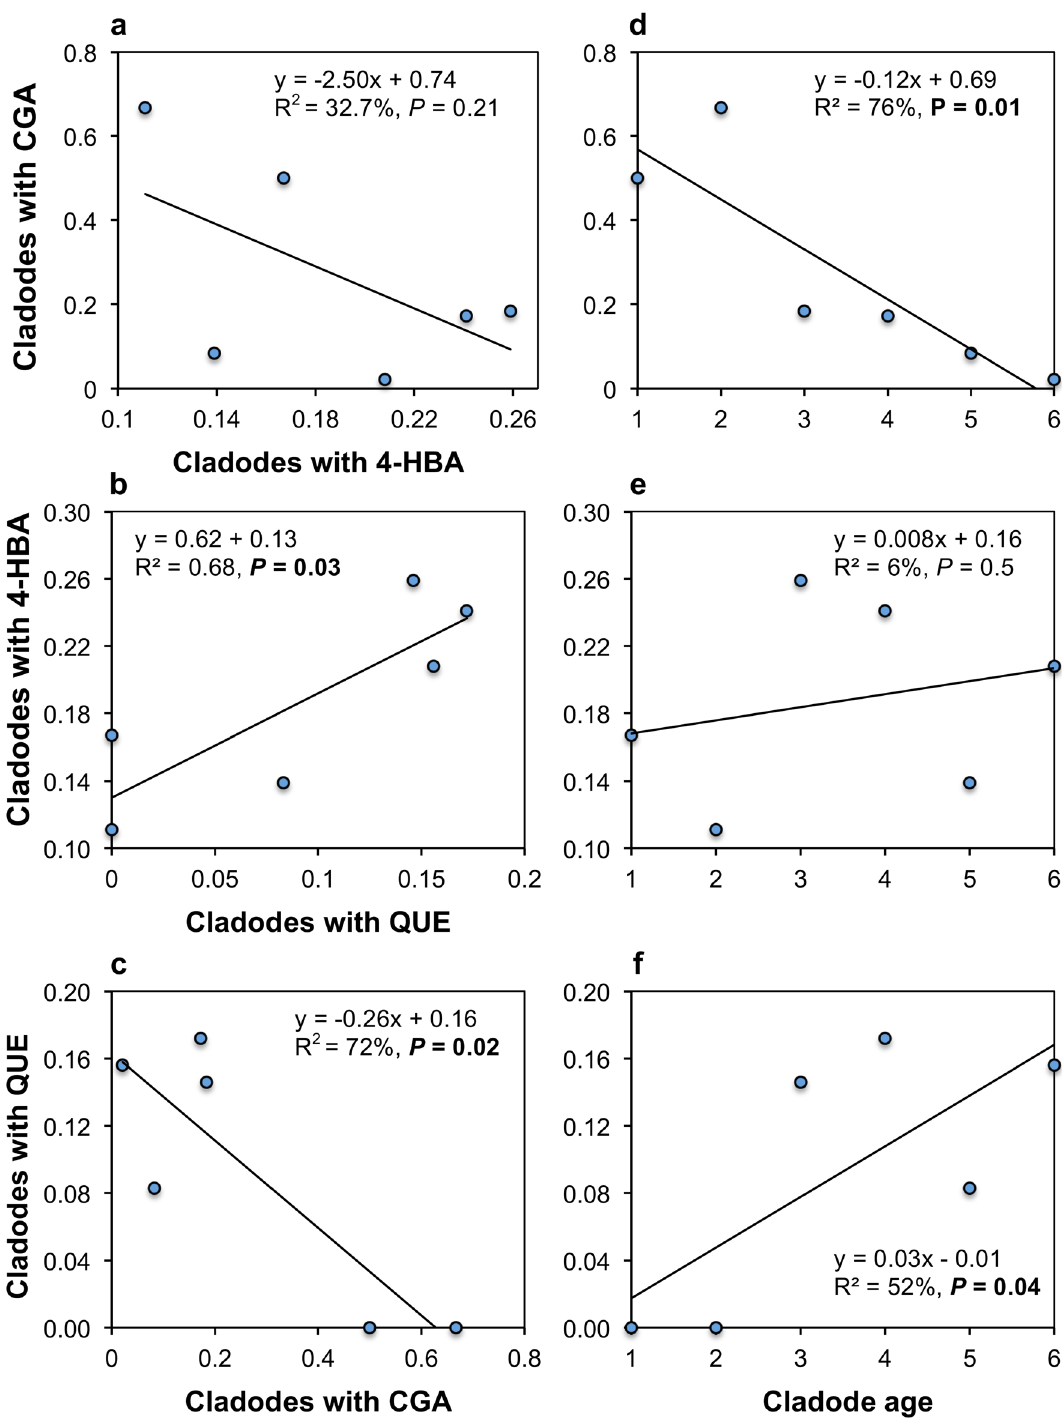
Figure 9. Relationship between the proportion of cladodes in the six age classes containing chlorogenic acid (CGA) and 4-hydroxybenzoic acid (4-HBA) ( a ), quercetin (QUE) and 4-HBA ( b ), and QUE and CGA ( c ), and the relationship between the average proportion of cladodes classified by age class, harbouring CGA ( d ), 4-HBA ( e ), and QUE ( f ). R 2 — coefficient of determination, P—t test probability for the coefficient of correlation. Significant relationships at P ≤ 0.5 are marked with bold